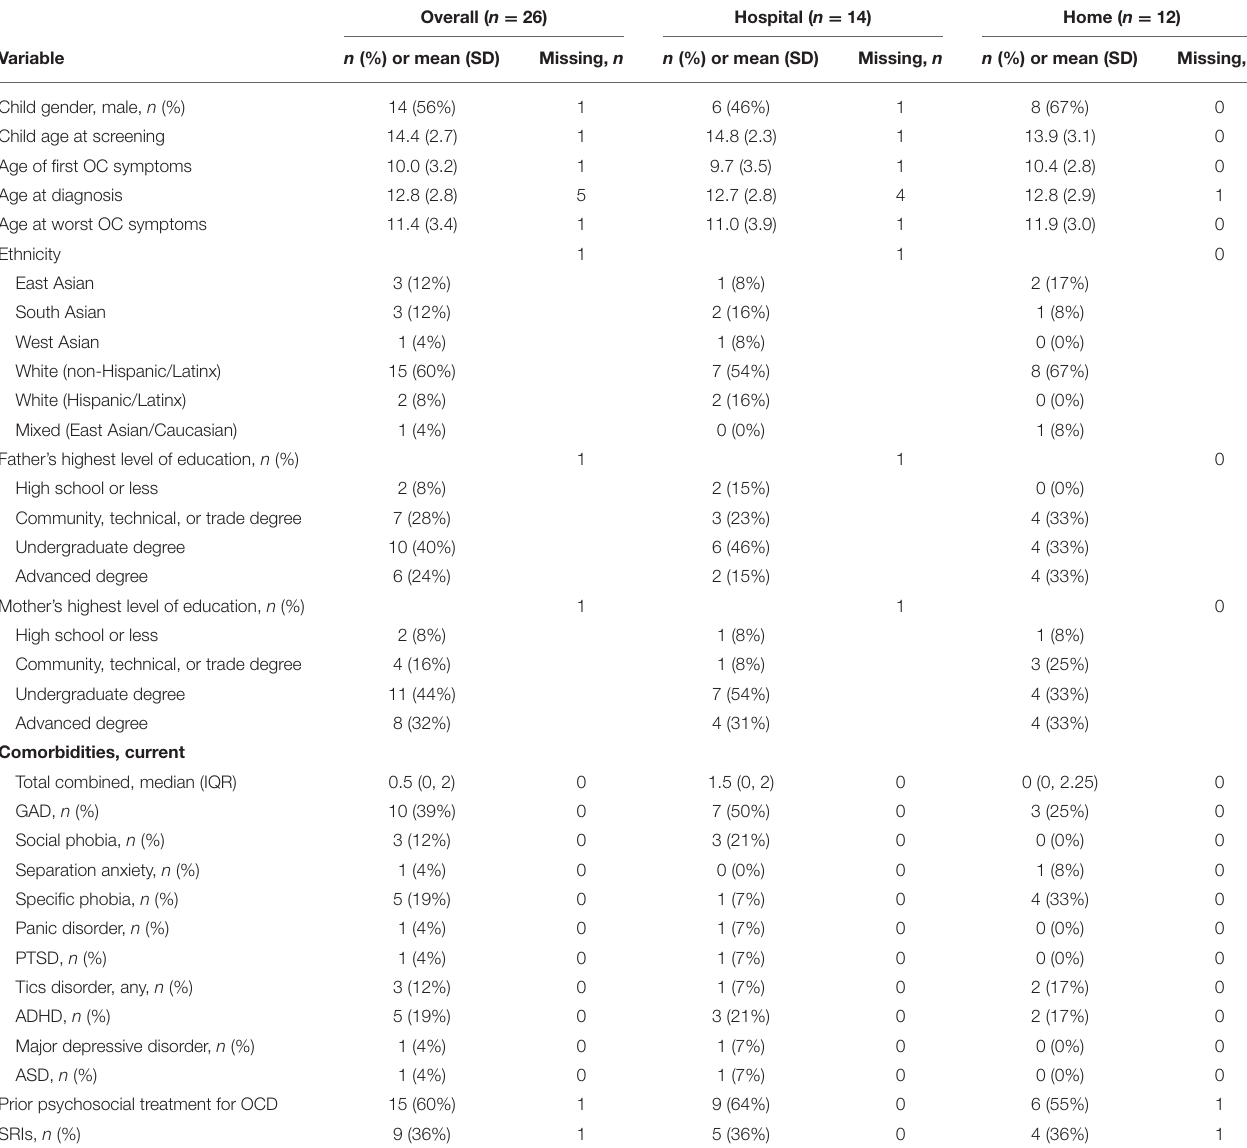
TABLE 2 | Baseline descriptive statistics for the full sample and within groups. Overall ( n = 26) Hospital ( n = 14) Home ( n = 12) Variable Missing, n Missing, n Missing,